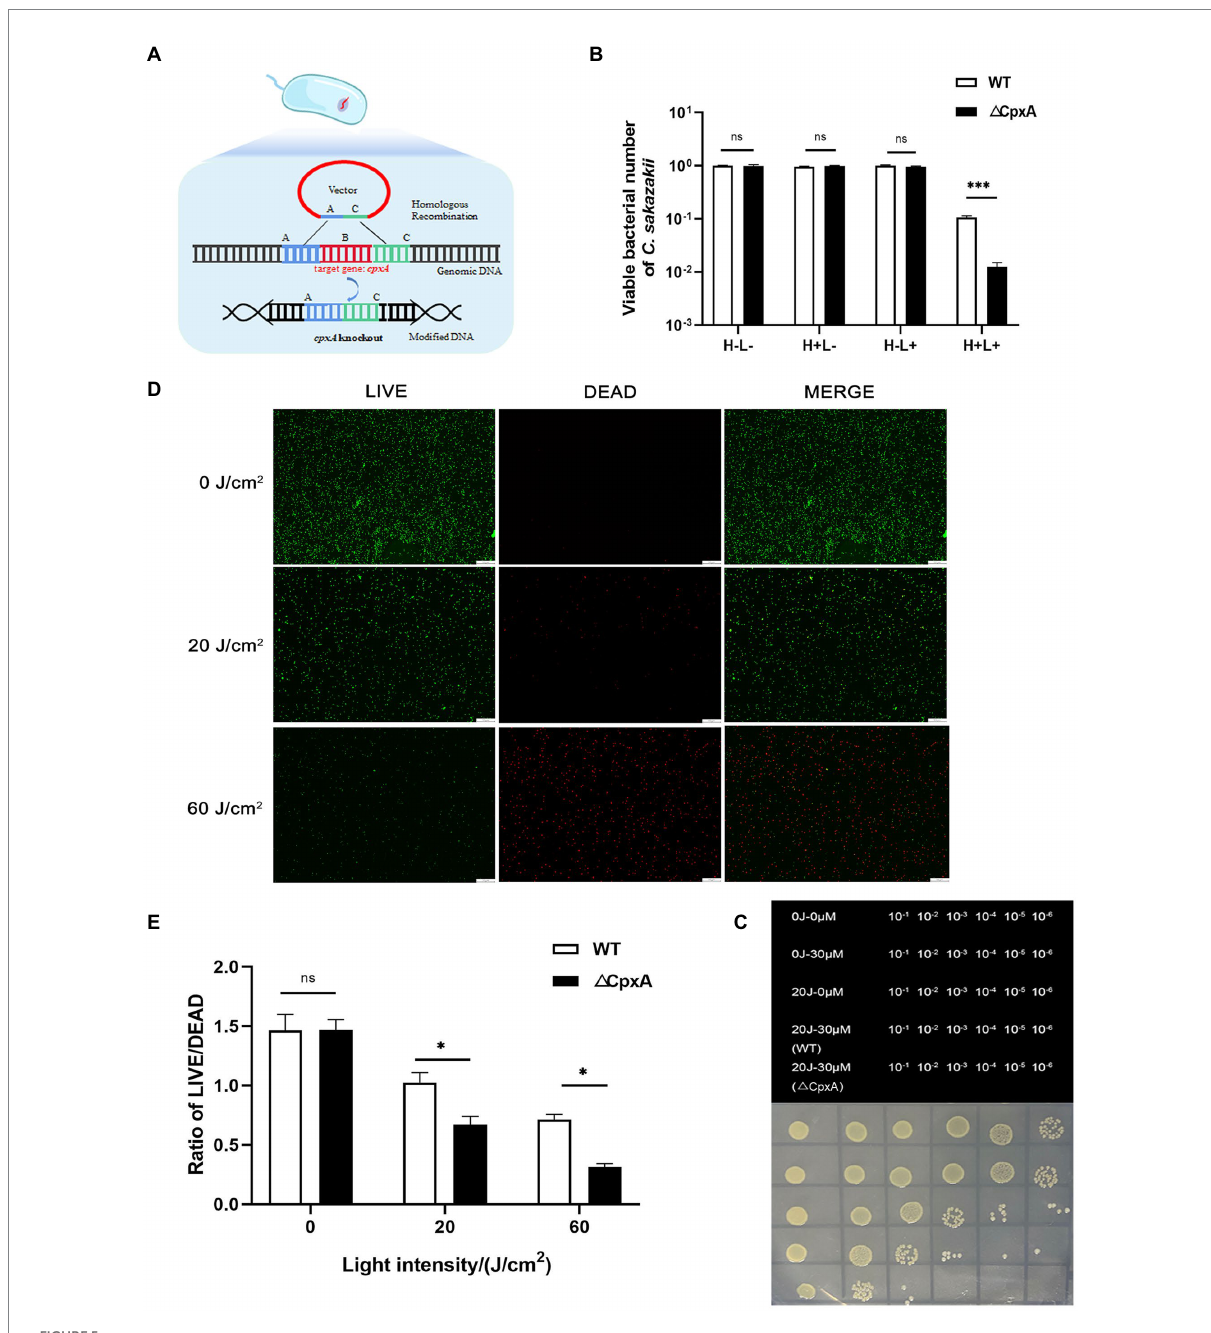
FIGURE 5 Effect of aPDI on the CpxA-knockout mutant. Δ CpxA mutant was constructed by means of suicide plasmid-mediated recombination (A) . The survival rates (B) of wildtype and Δ CpxA were compared under the condition of 20 J/cm 2 light-30 μ M HB. The representative dot-plating graphs were also shown as categorized by various dilutions (C) . Three control groups (blank, light only and HB only) were designed to indicate the aPDI effect. To validate this effect, the LIVE/DEAD double staining of both strains were performed, and green (live), red (dead) and merged images were obtained from fluorescence microscopy (D) . The scale bar represents 50 μ m. The quantification was conducted using Image J software (E) . H-L-, blank control; H+L-, single HB-treated group; H-L+, single light-treated group; H+L+, the aPDI-treated group. Values are the mean ± SEM (standard error of mean) from 4~6 replicates. * p < 0.05, ** p < 0.01, *** p <